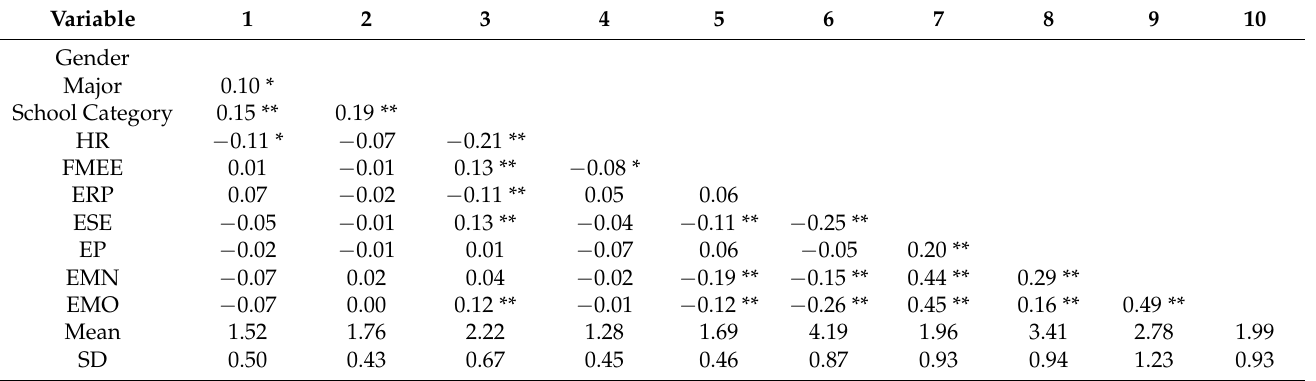
Table 3. Mean, standard deviation, and correlation coefficient of variables (n =